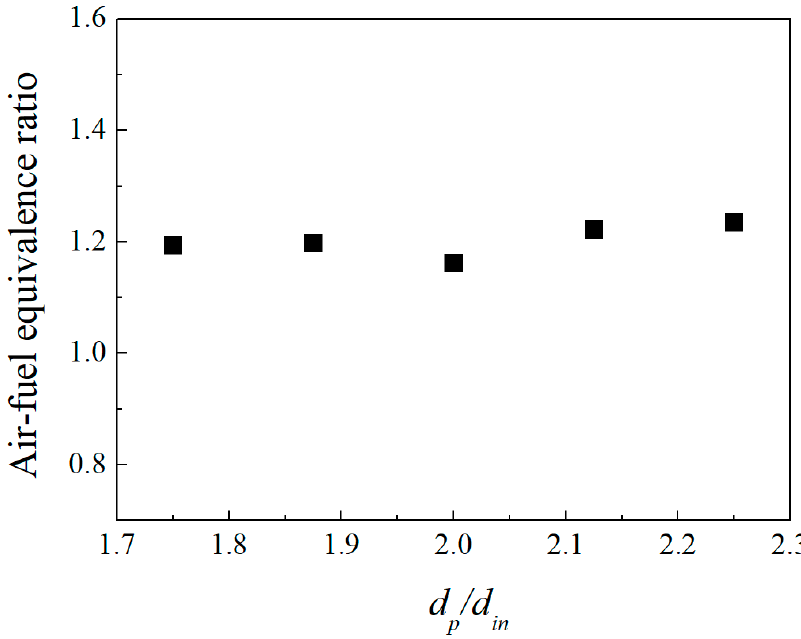
ff erent sudden expansion ratio with d